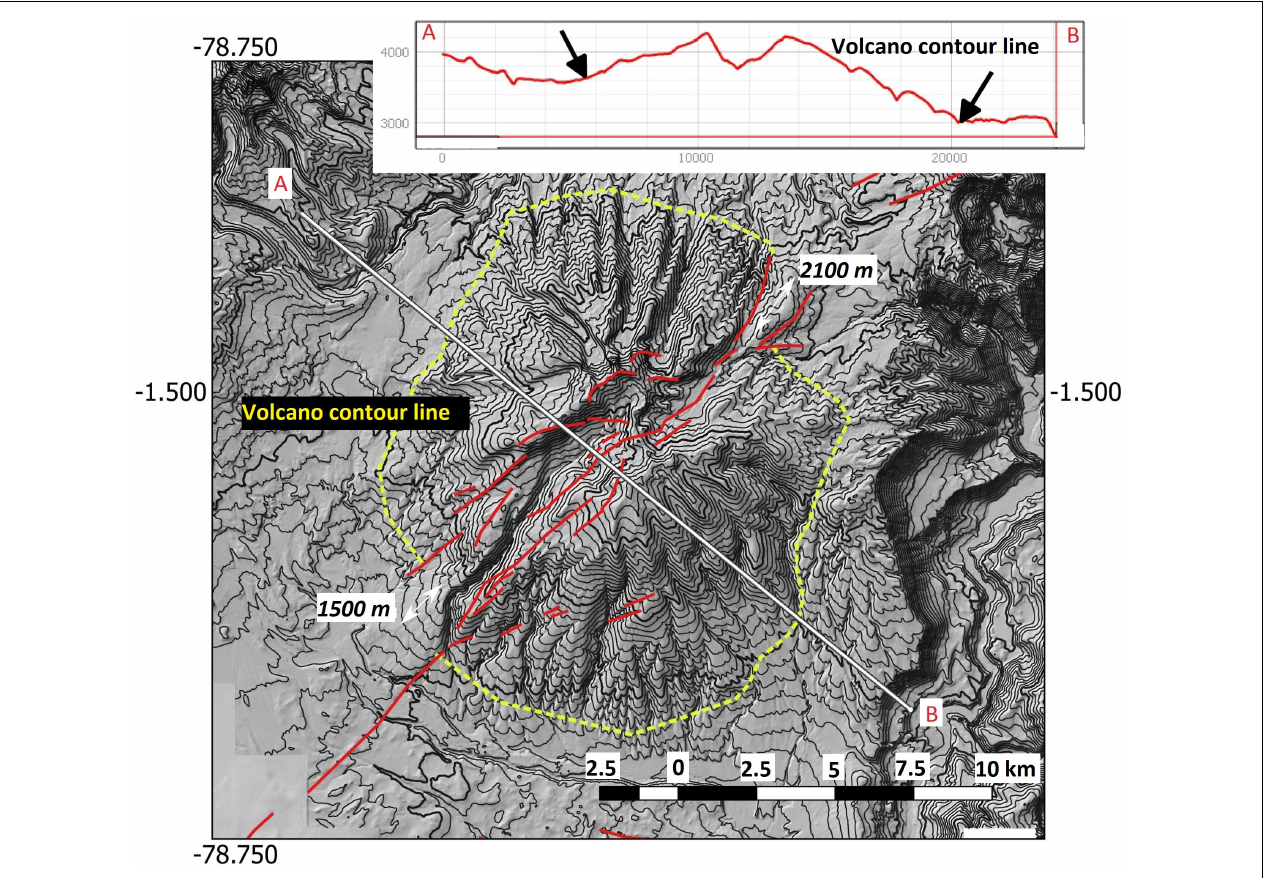
FIGURE 7 | Topographic map of the Igualata edifice with hill-shade DEM picture and related elevation contours (contour spacing: 100 m; bold contour each 1000 m). Based on topographic profiles across the edifice (one profile is presented as an example with black arrows in the mean NW-SE direction), we traced the base of the edifice at the change in slope (yellow dashed line) and, assuming a rough cylindrical initial shape, we infer a right-lateral displacement of the whole volcano since its setup (1500–2100 m). Red lines are the morphotectonic lineaments forming the fault